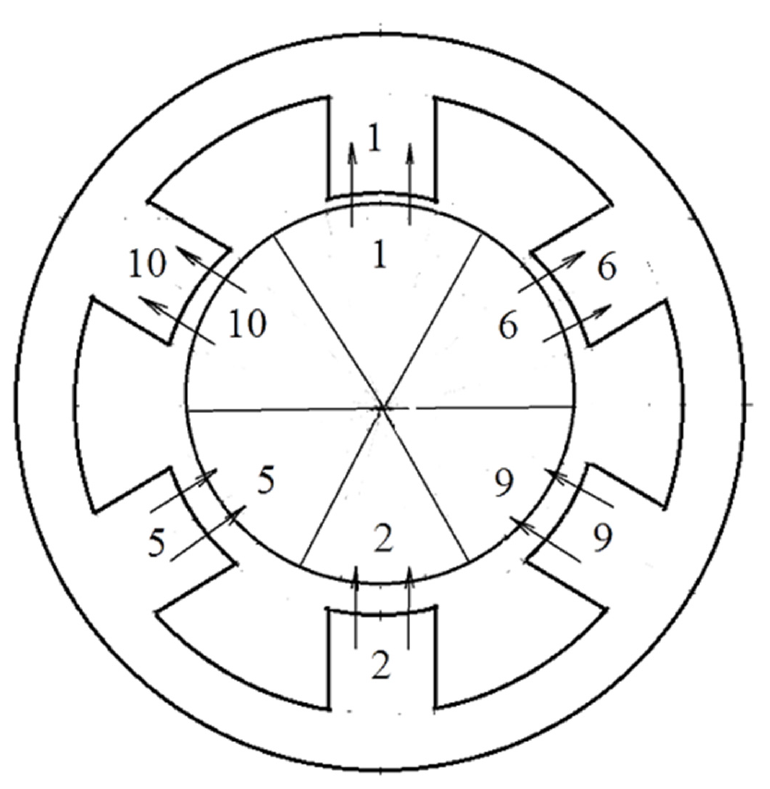
Figure 3. Determination of the magnesium conductivity of the air gap with a fixed position of the rotor.